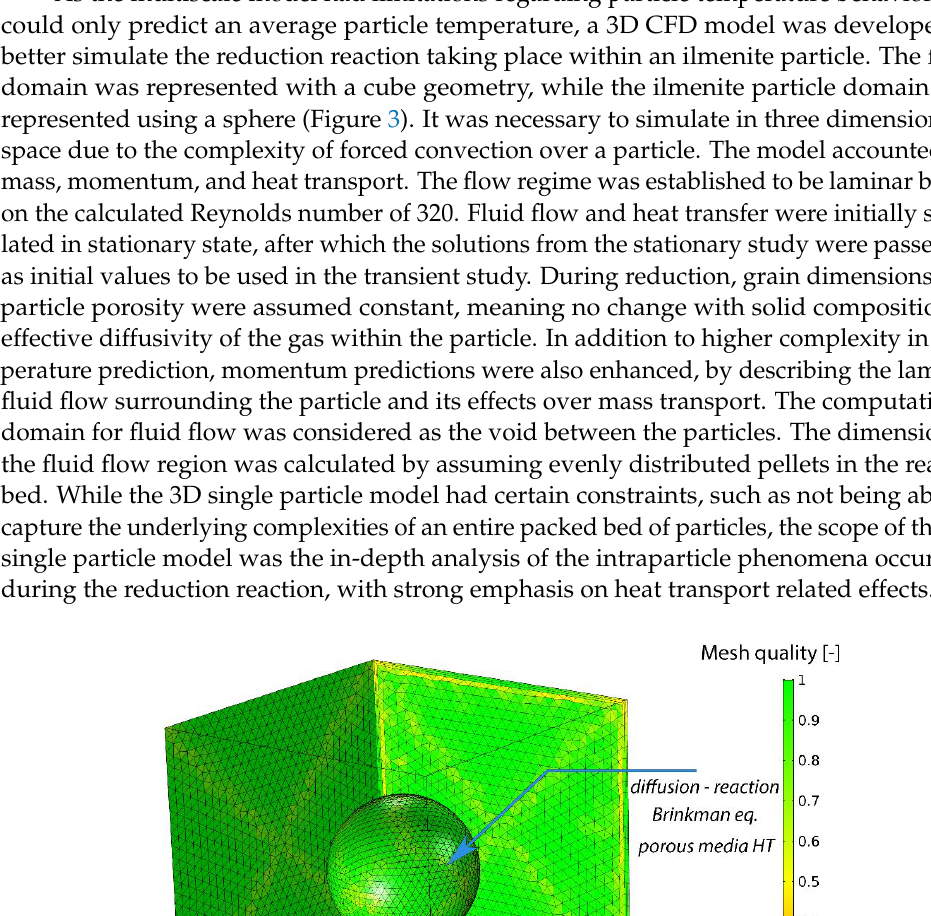
Table 2. Parameters used in the fuel reactor model [11].